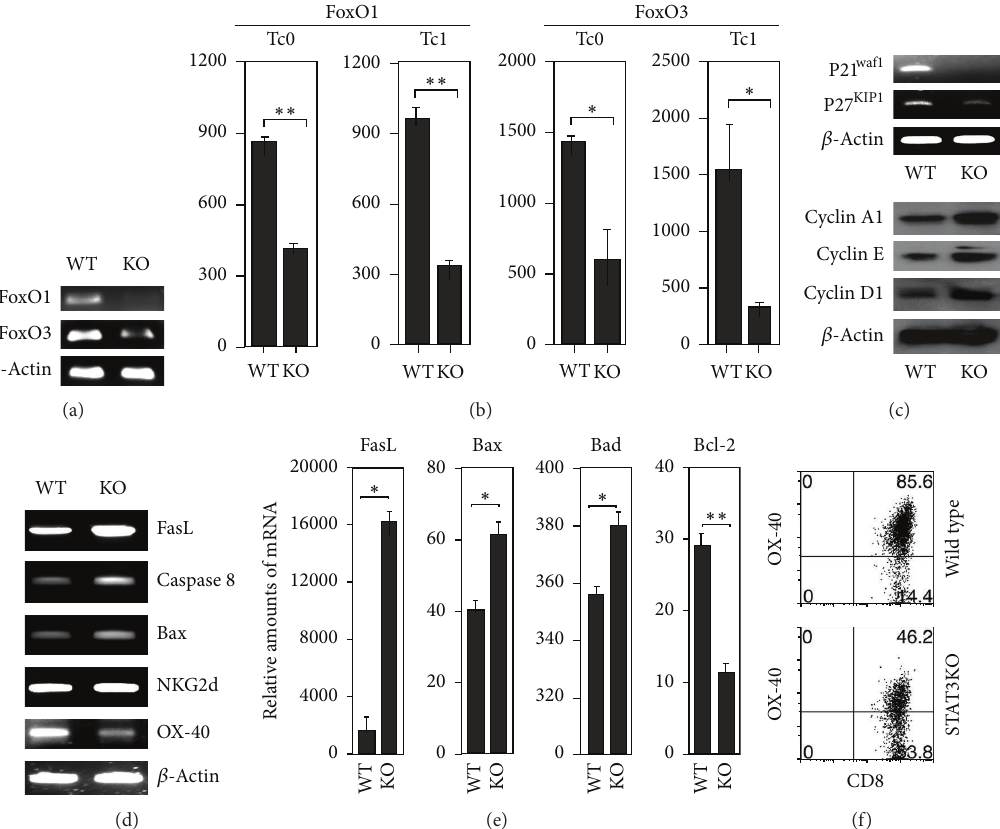
Figure 3: Enhanced proliferation and sensitivity to AICD of STAT3-deficient CD8 + T cells correlated with alterations in the expression of proapoptotic, antiapoptosis, and cell-cycle regulatory genes. Na¨ıve CD8 + T cells were cultured for 4 days under Tc0 and Tc1 polarization condition. RNA was isolated and analyzed by RT-PCR (a, c, d) or qRT-PCR (b, e). (f) Na¨ıve CD8 + T cells were cultured for 4 days under non- polarizing condition, and expression of OX-40 was detected by FACS. Numbers in quadrants represent percentage of CD8 + T cells expressing OX-40. Data represent at least 3 independent